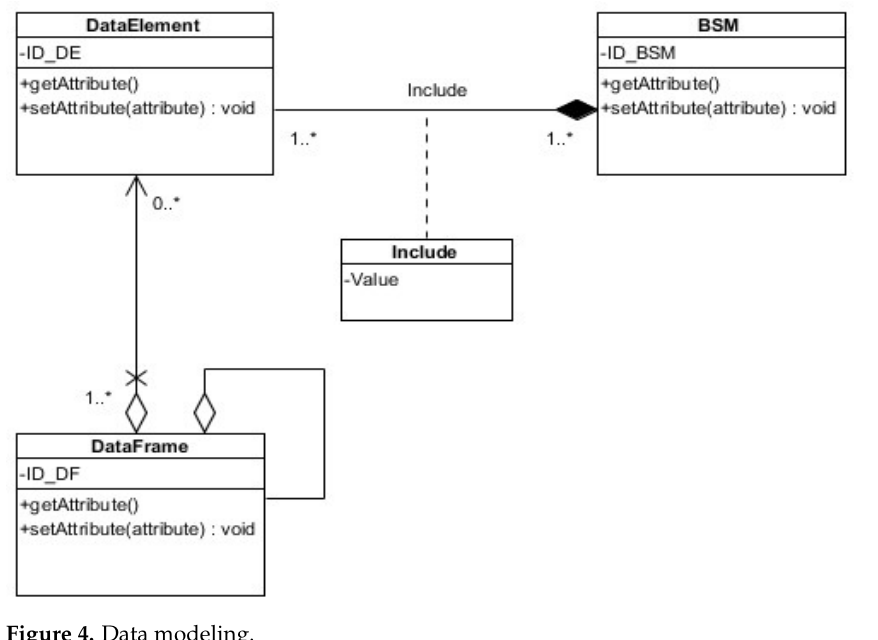
Figure 4. Data modeling. Table 4. Summary values of the data elements of the Part 1